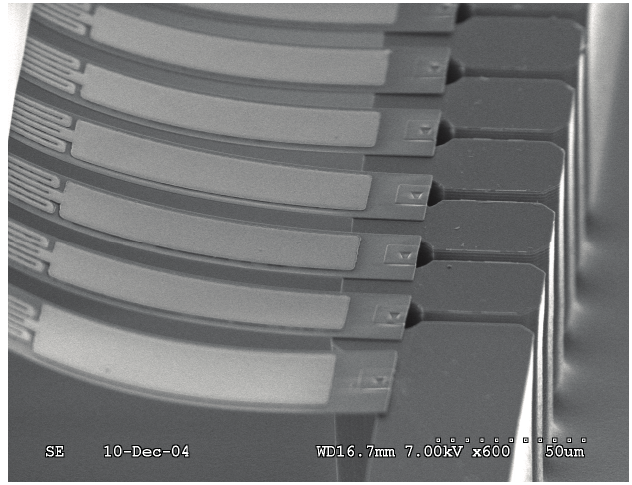
Figure 4. Optical microscopy image of micro-fabricated bimorph microcantilever array integrated with heating element at their